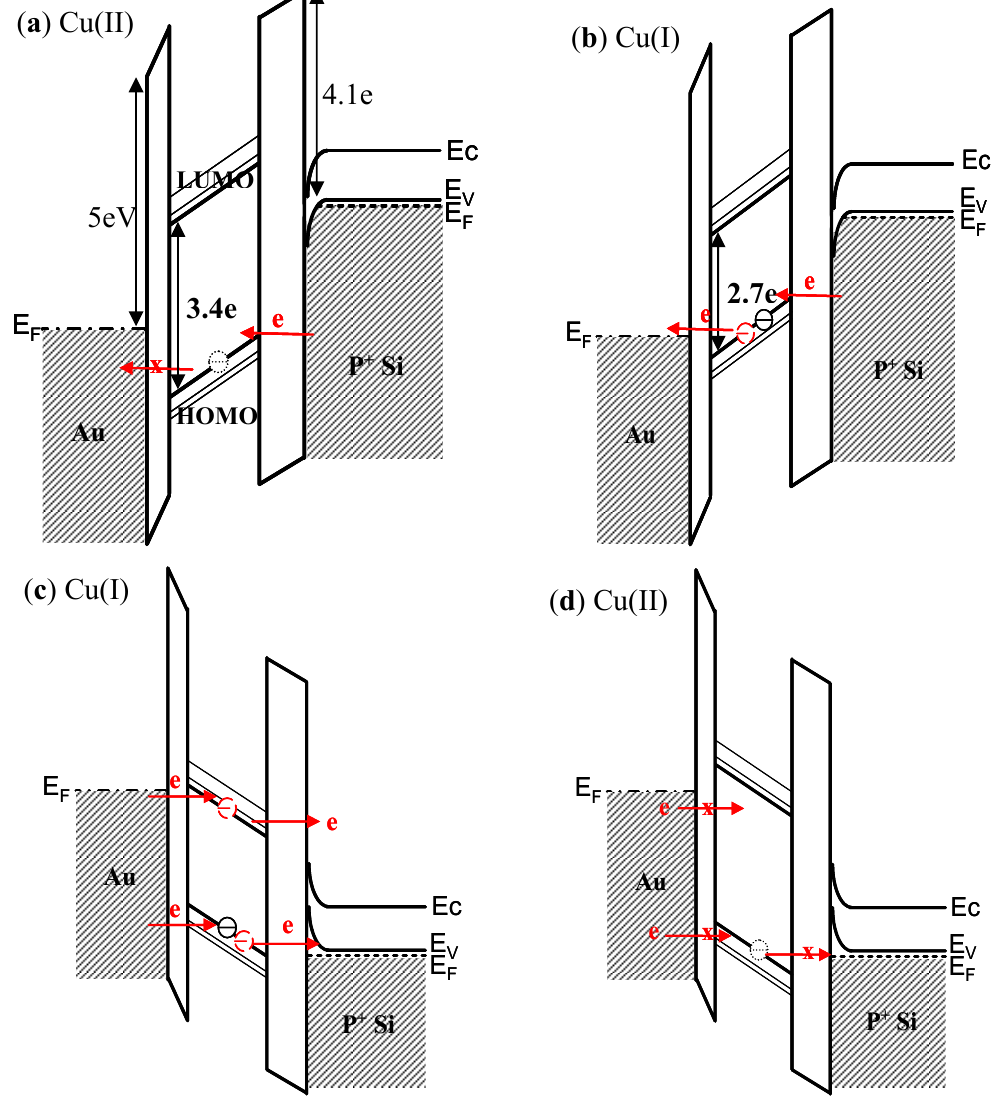
Figure 8. Band diagram of ( a ) low conductivity state of Cu(II) system under positive bias; ( b ) high conductivity state of Cu(I) system under positive bias; ( c ) high conductivity state of Cu(I) system under negative bias; and ( d ) low conductivity state of Cu(II) system under negative bias. ( a )